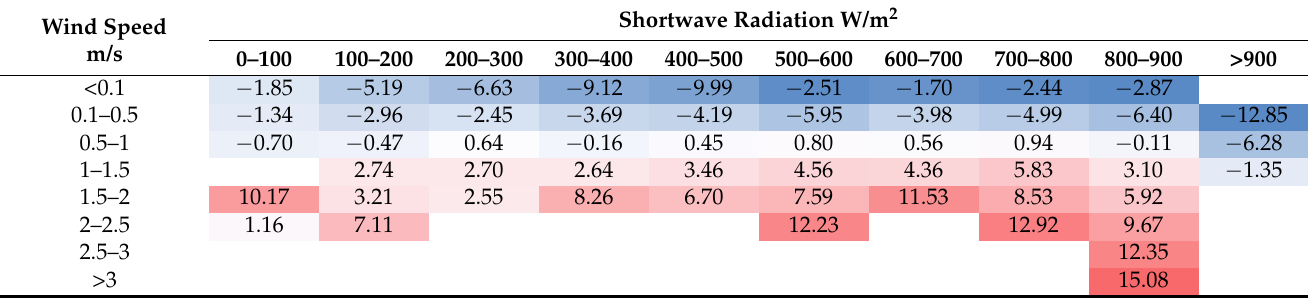
Table 5. Statistics of dTmrt results of various wind speed values and temperature ranges (air temperature range of 29–34 ◦ C).